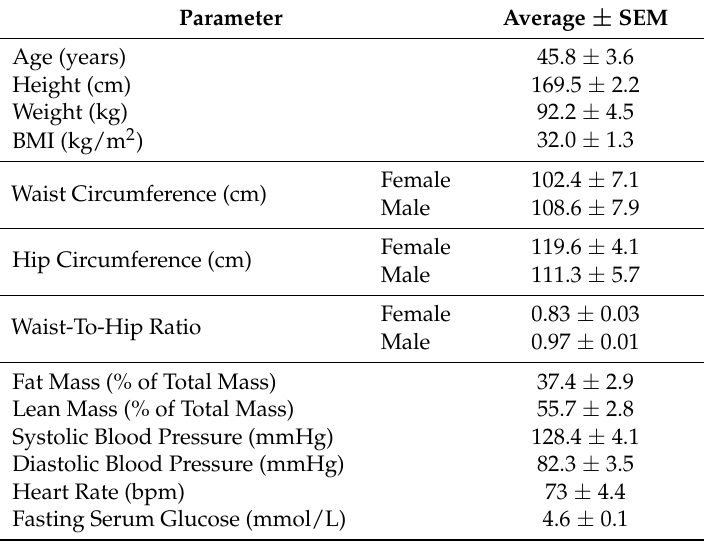
Table 2. General participant